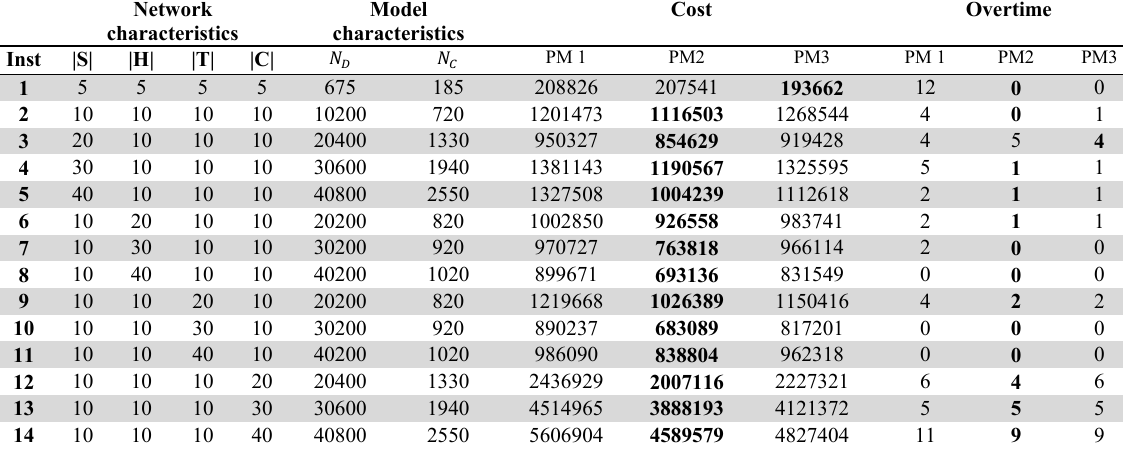
Computational results obtained using the standard NSGA, the HNSGA approach and the GRASP with ILS for the mono-objective problems Network